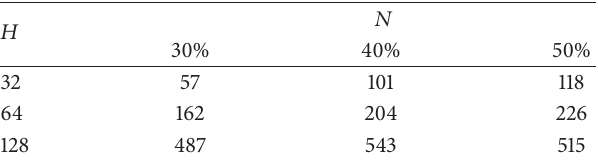
Table 2: Number of support vectors for different training image noise ratios and sizes. These numbers include support vectors for detecting both black and white noisy